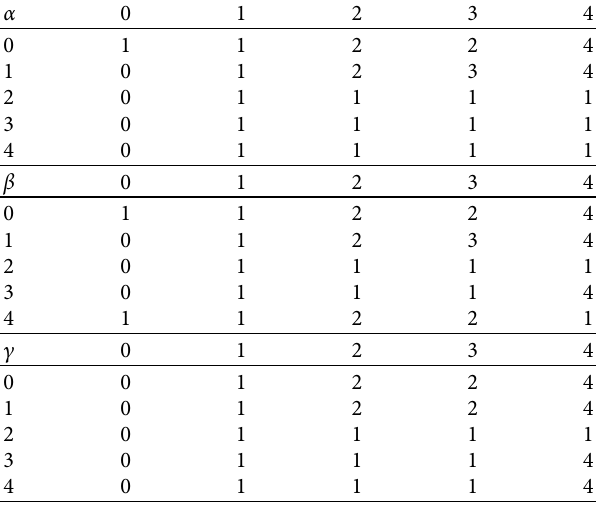
Te next example shows that two conditions (36) and (37) are independent of each other if ( X, 1 ) is not strong. Γ Tat is, if ( X, 1 ) is a Γ ( -BE-algebra which is not strong, Γ α , β )